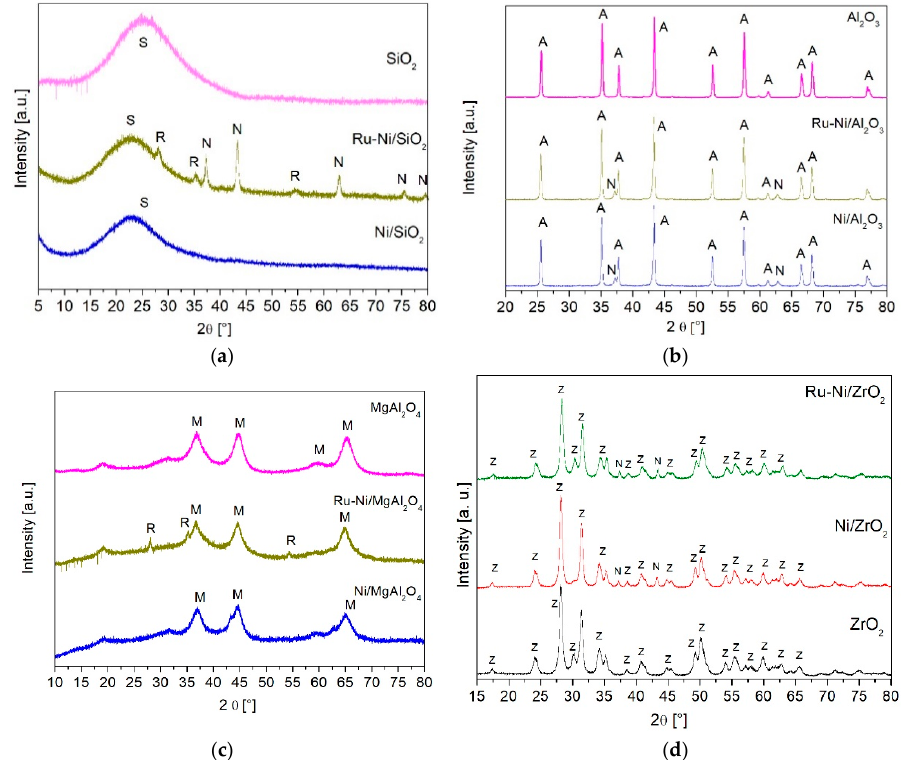
Figure 1. XRD patterns of nickel and ruthenium–nickel catalysts supported on ( a ) SiO 2 , ( b ) Al 2 O 3 , ( c ) MgAl 2 O 4 , and ( d ) ZrO 2.